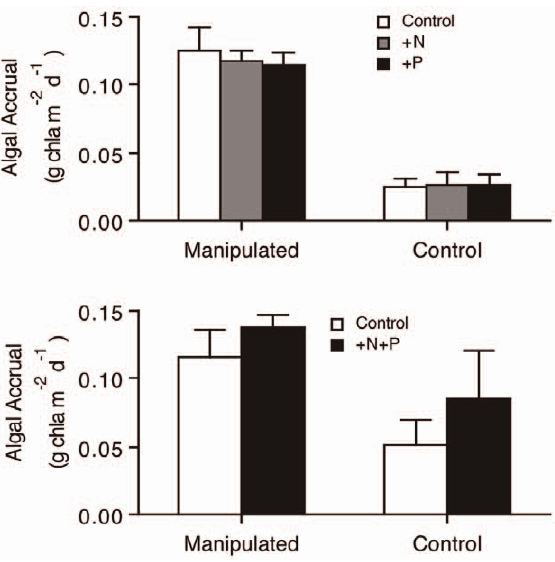
Figure 3. Algal Responses (mean ± 1 se) to Nutrient Addition in River Reaches with Intact (Control) and Manipulated Riparian Vegetation. All responses measured as rates of chlorophyll a accrual. Top: results from single nutrient manipulations of nitrogen (as NaNO 3 ) and phosphorous (as NaH 2 PO 4 ). Bottom: results from simultaneous nutrient additions using Osmocote pellets (18 N: 6 P).